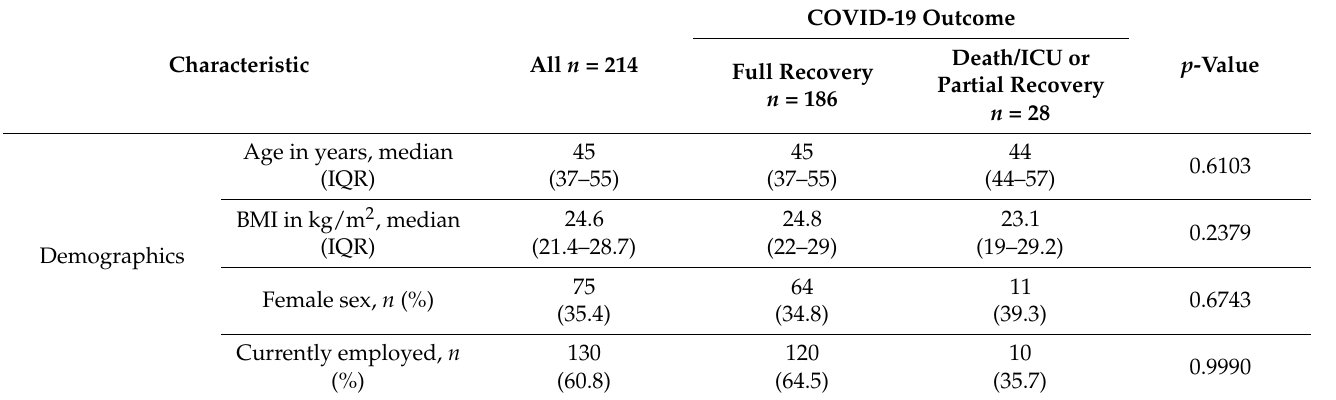
Table 2. Baseline characteristics of HIV/COVID-19 co-infected patients, stratified by COVID-19 outcome.